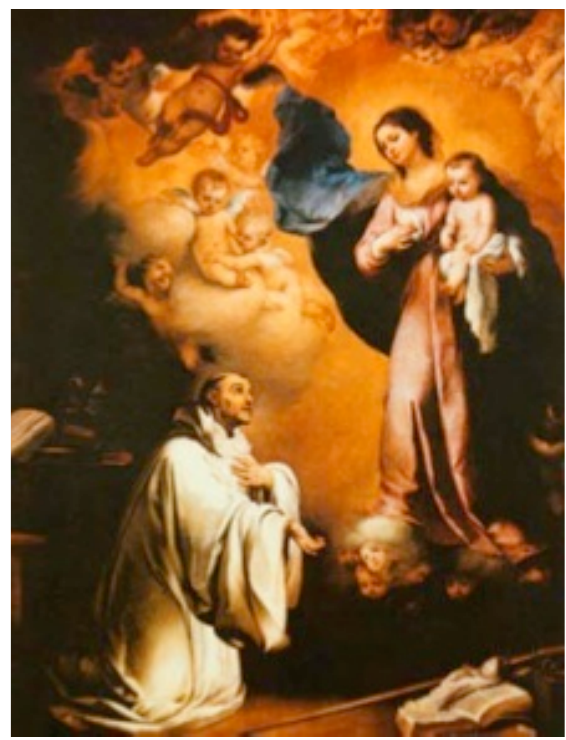
Fig. 3. Bartolomé Esteban Murillo, The Apparition of the Virgin to St. Bernard of Clairvaux , c. 1660. Oil on canvas, 311 x 249 cm. Museo del